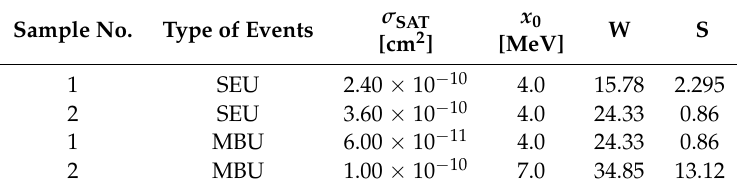
Table 8. Weibull function parameters for SEU and MBU event types based on the OMERE software algorithm.